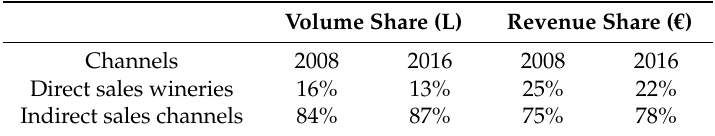
Table 3. Calculated market share direct vs. indirect wine sales